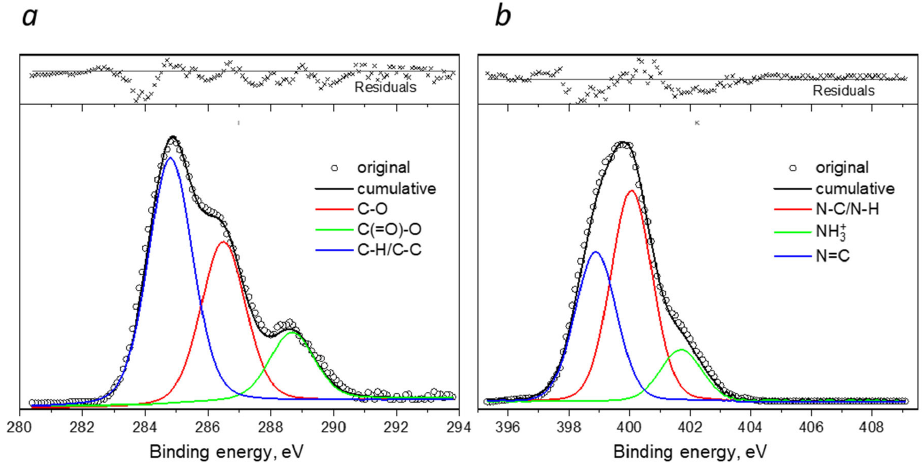
Figure 4. Deconvoluted XPS spectra: ( a ) C1s for silochrom/PLA and ( b ) N1s for silochrom ‐ NH 2 /PLA.